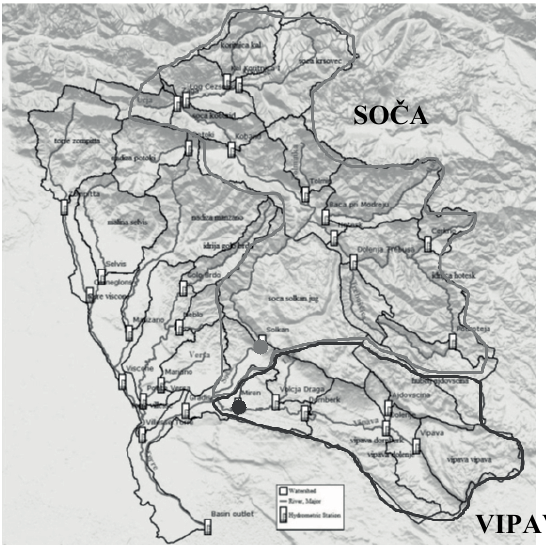
Fig. 1 River gauging